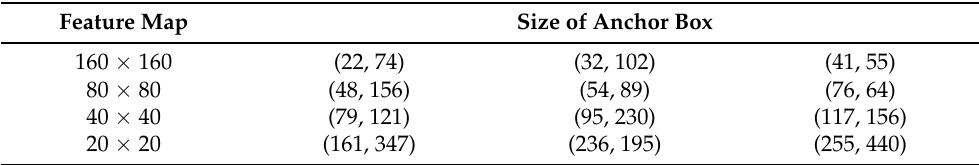
Figure 10. Clustering results. ( a ) Average IOU. ( b ) Visualization of the selected anchor boxes. Table 1. The size of anchor boxes for the four feature